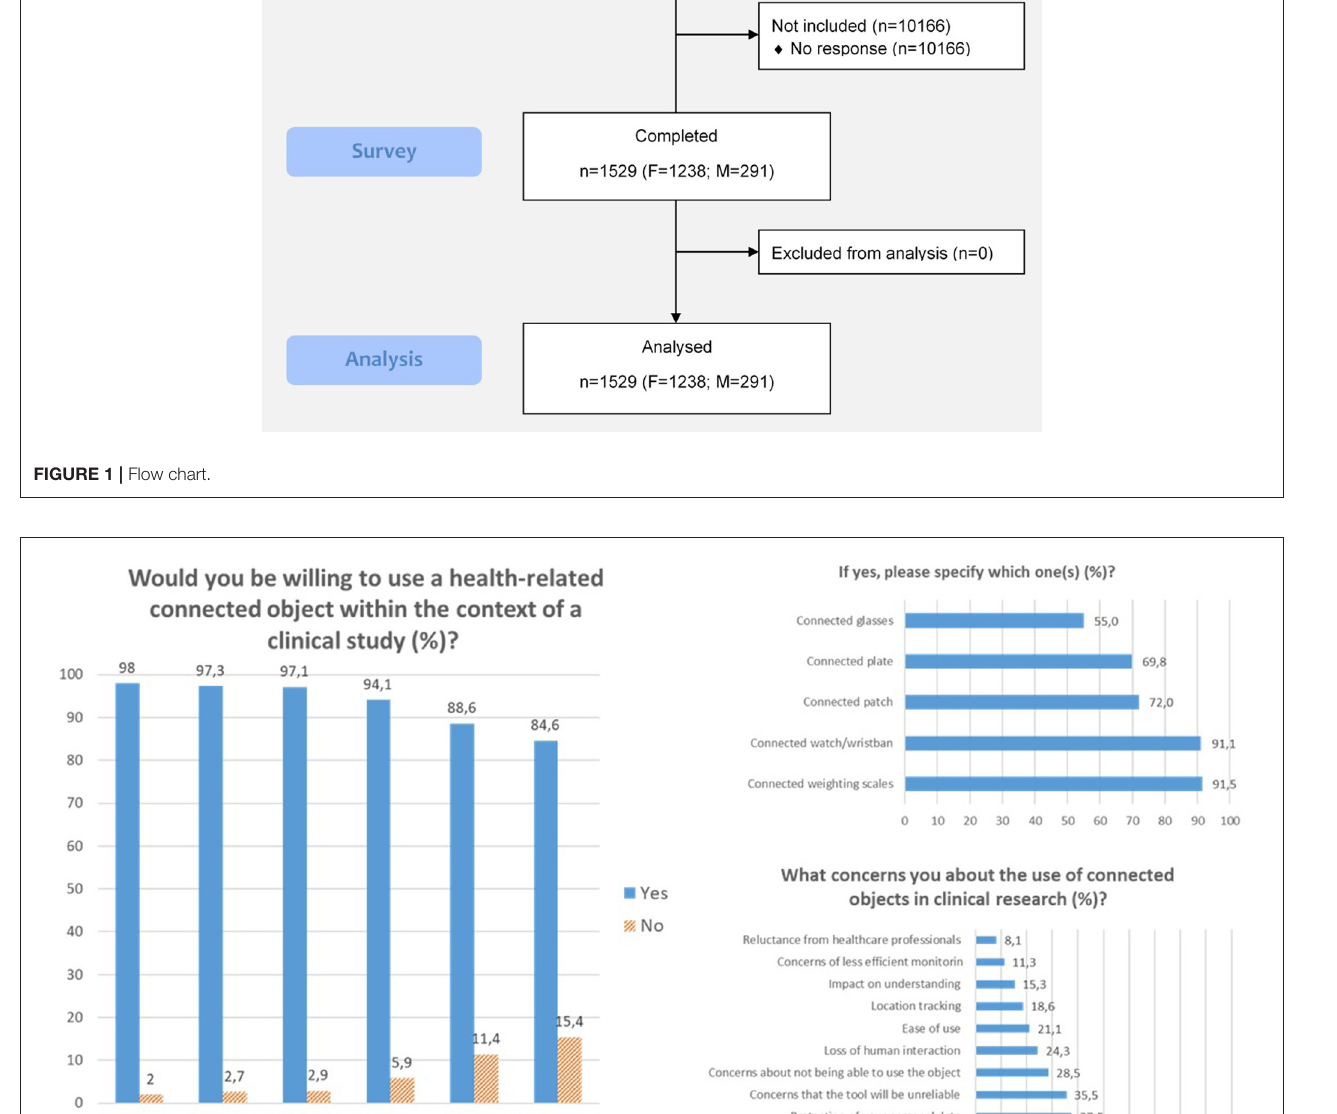
performed using SAS v9.4 R (cid:13) . A margin error of 5% was used for statistical